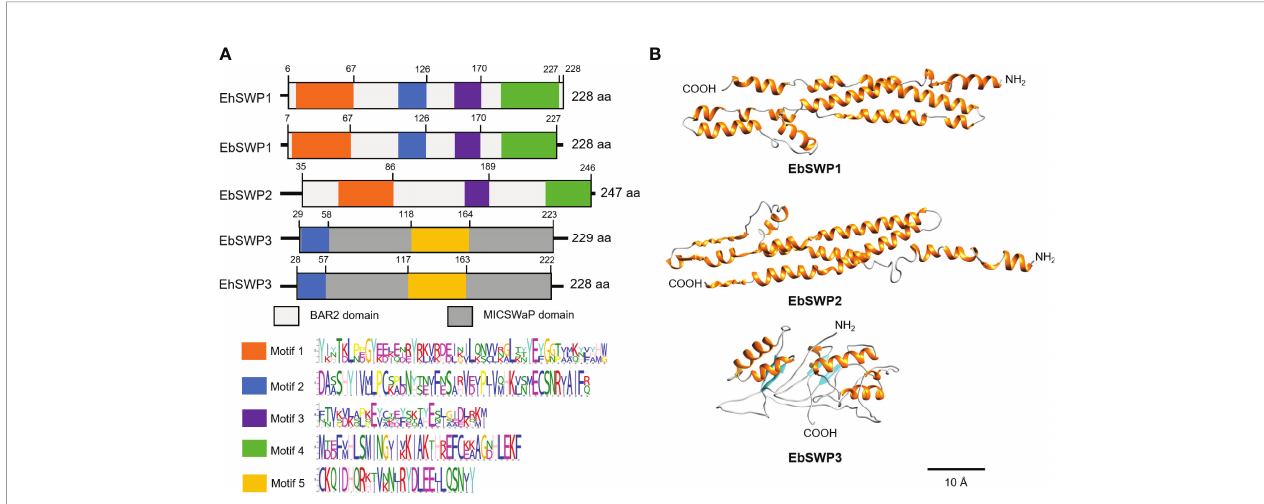
FIGURE 1 | Sequence characteristics of EbSWP. (A) Domains and motifs in four microspore wall proteins. EhSWP1, EbSWP1 and EbSWP2 have the same BAR2 domain, while EbSWP3 has a MICSWaP domain. Altogether, fi ve motifs were identi fi ed using MEME Suite. EbSWP1 contains the same motifs as EhSWP1, with some difference from motifs in EbSWP2, and signi fi cant difference from the motif in EbSWP3. (B) Structures of EbSWPs predicted by I-Tasser. EbSWP1 has 15 a - helices separated by coils (C-score = -1.13 in the range of -5 to 2) while EbSWP2 has 9 a -helices (C-score = -1.75). None of them have b -stands. In contrast, EbSWP3 contains 6 a -helix and 4 b -strands (C-score = -3.97). The a -helices are colored in orange, the b -stands are in cyan, and the coil are in gray. The N terminus and the C terminus are also labeled (Bar = 10